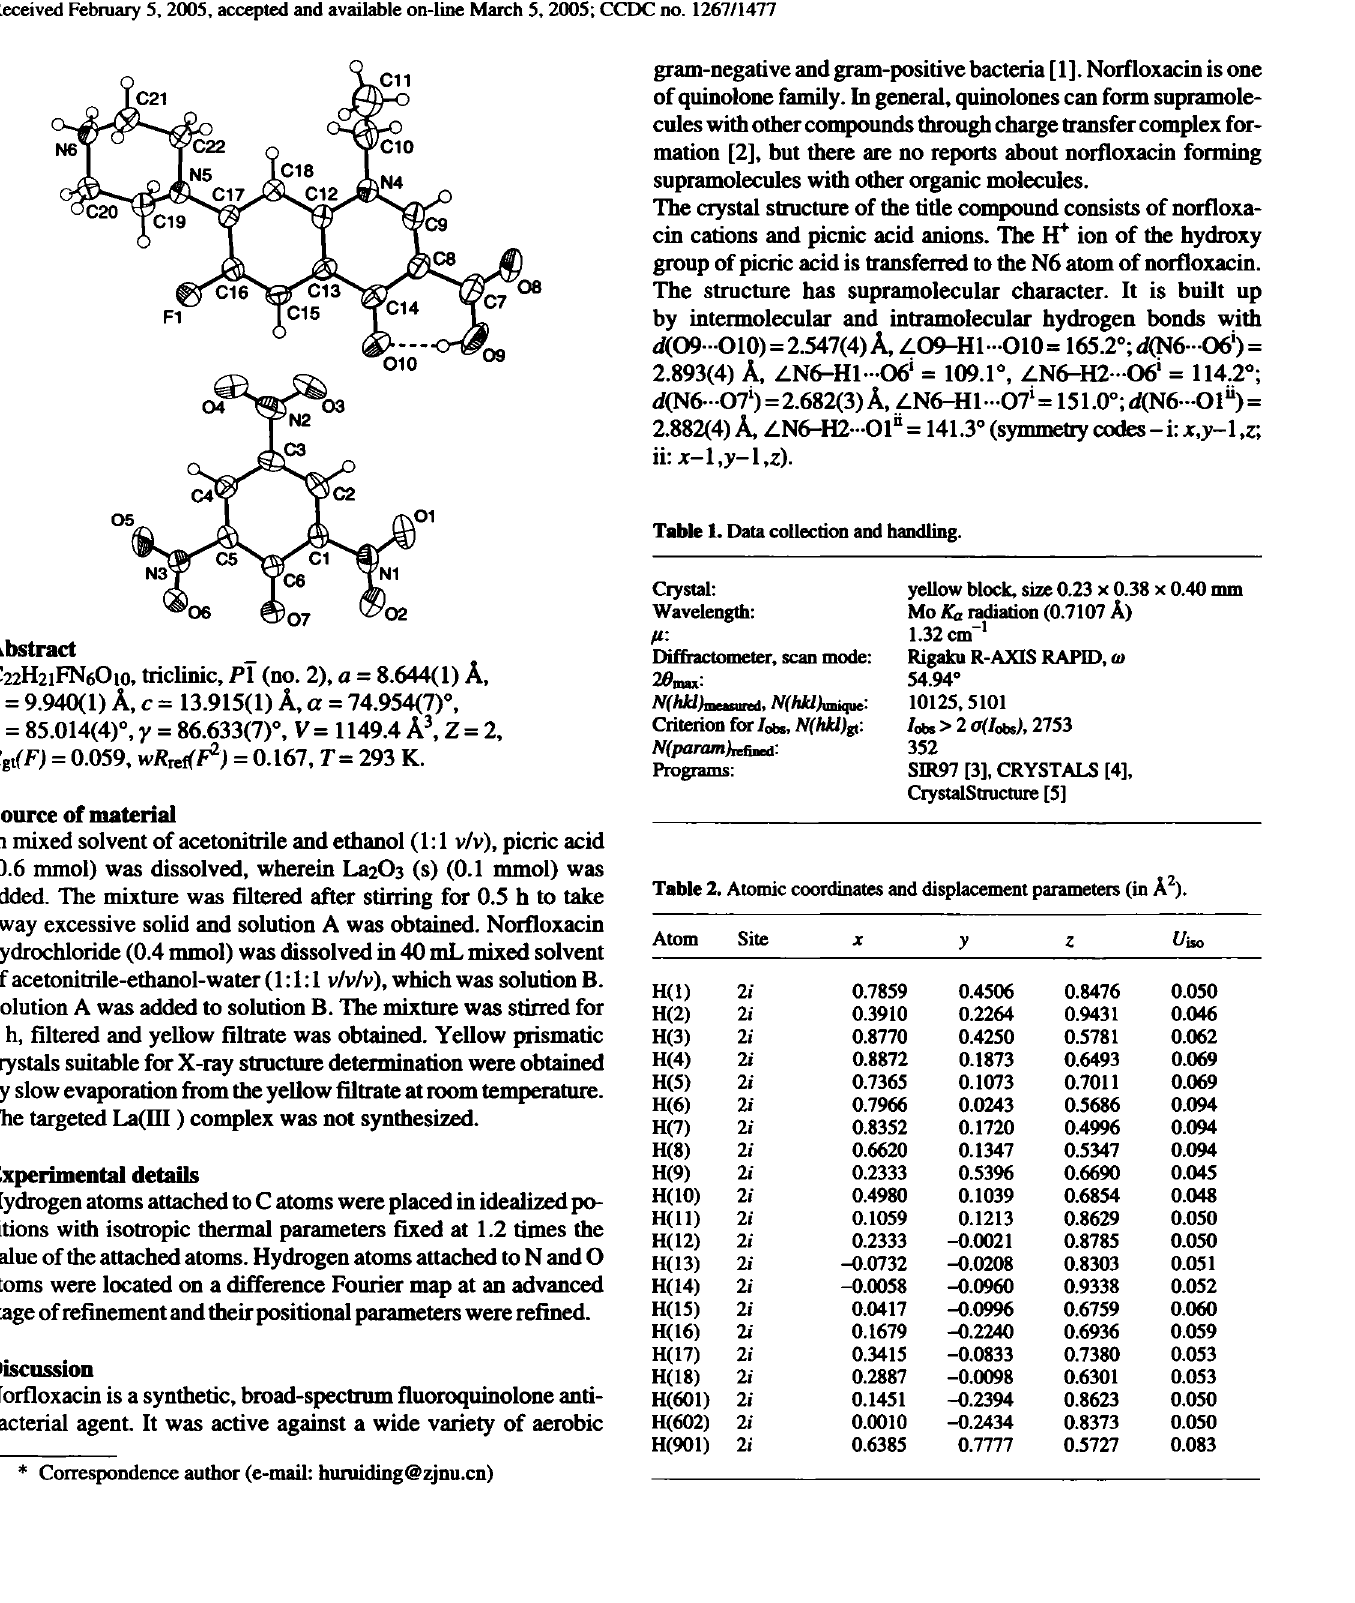
Table 1. Data collection and handling.